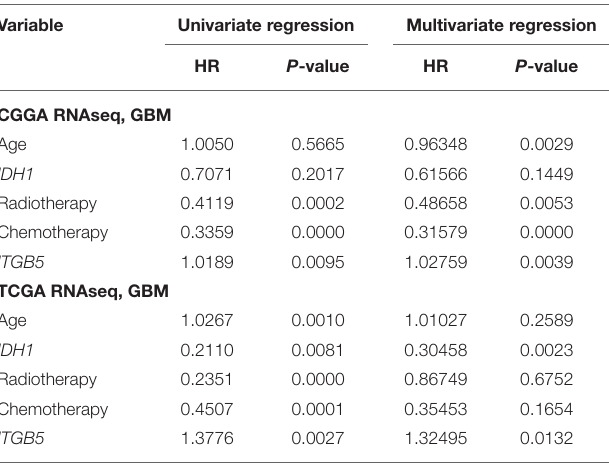
TABLE 1 | Univariate and multivariate Cox regression analyses of ITGB5 in CGGA and TCGA RNAseq datasets and overall survival of GBM patients.